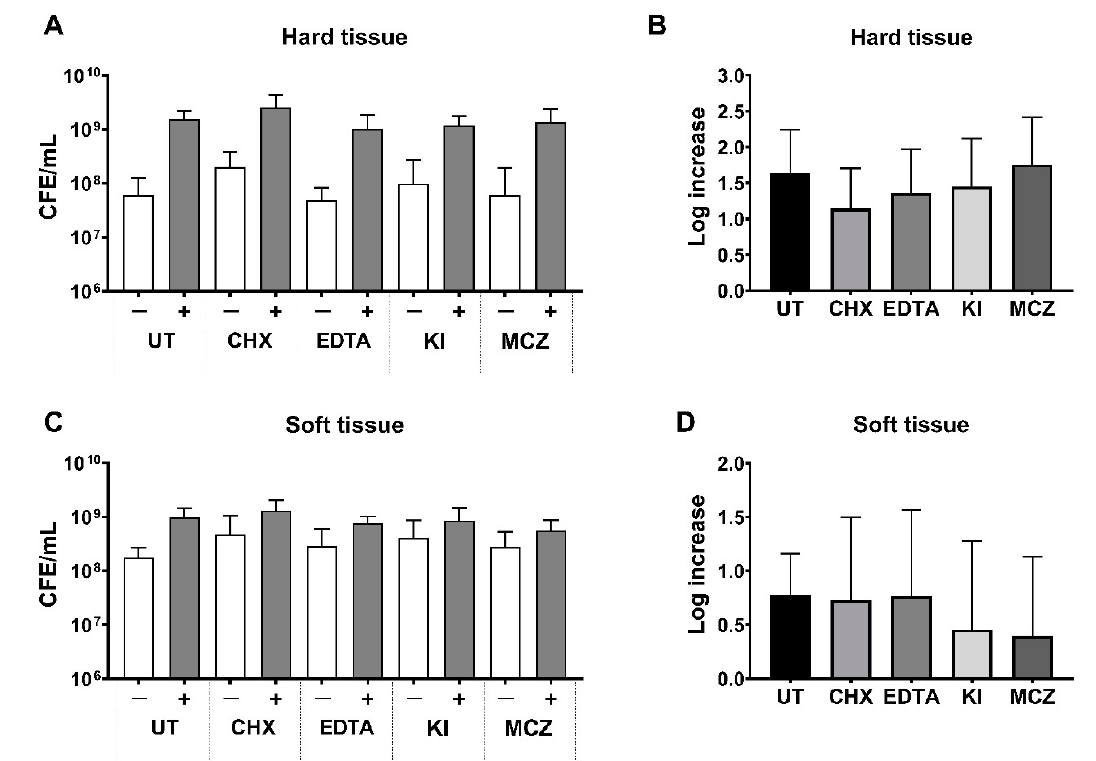
Figure 6. Bacterial load following 10 min treatment of hard and soft tissue biofilms plus or minus C. albicans . Following growth and removal of the biofilm from the microtiter plate, DNA was extracted using the QIAamp DNA Mini Kit, and bacterial load was assessed using 16S PCR. Data represent mean ± SD, experiment carried out in duplicate from three independent experiments. The total bacterial load (shown as colony forming equivalent (CFE) per mL) is shown for HT biofilms ( A ) and ST associated biofilms ( C ). The white bars are indicative of bacterial-only biofilms, whilst grey bars show the biofilms containing C. albicans . The fungal loads (quantified using 18s qPCR) of the biofilms were also assessed in the C. albicans- containing biofilms and total CFE/mL counts are documented in Table 3. Log increase, HT, caries associated biofilms ( B ) and ST associated biofilms ( D ) of biofilms with or without C. albicans . No significant differences were observed between untreated and treated samples using a Mann–Whitney t test.